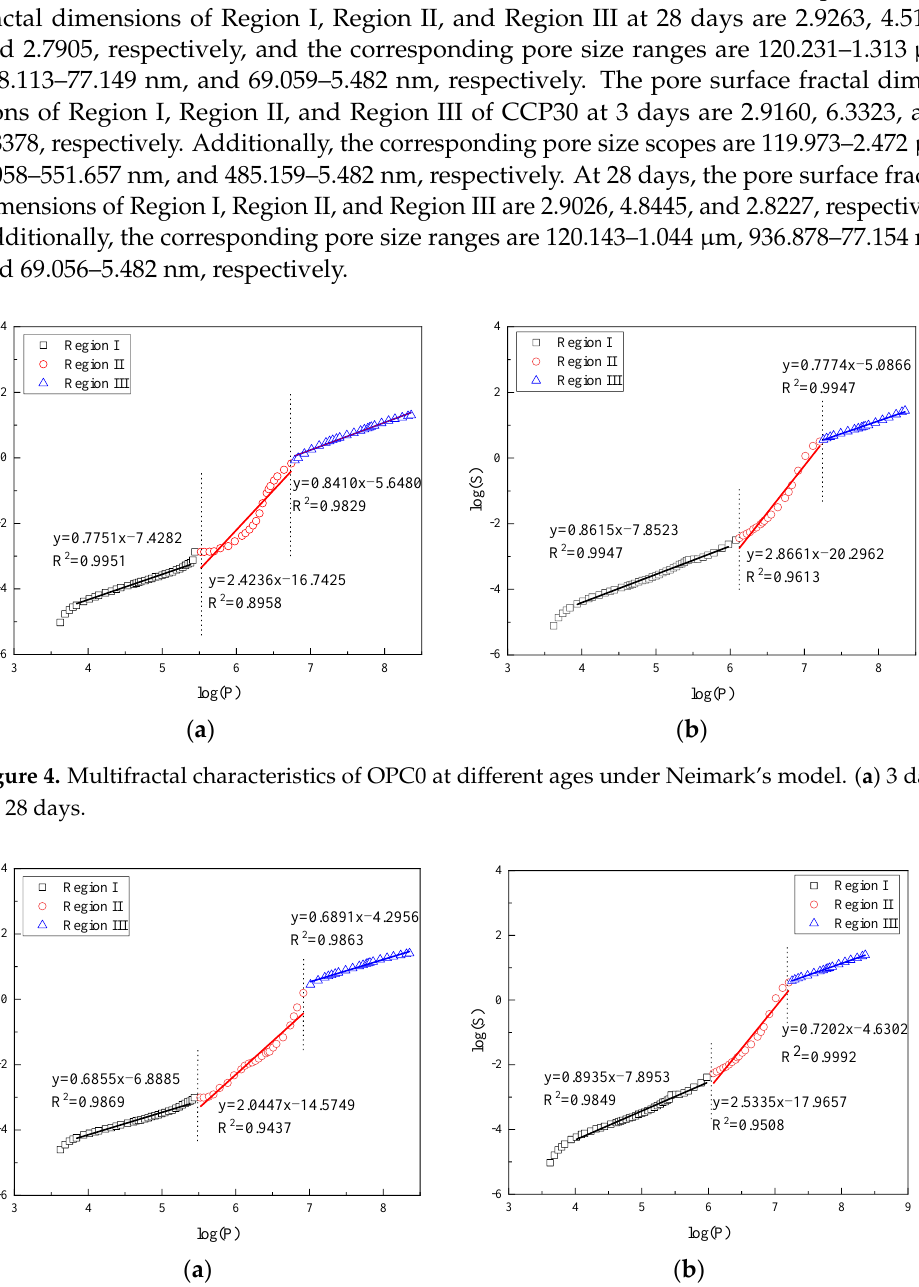
Figure 5. Multifractal characteristics of FCP10 at different ages under Neimark’s model. ( a ) 3 days, ( b ) 28 days.